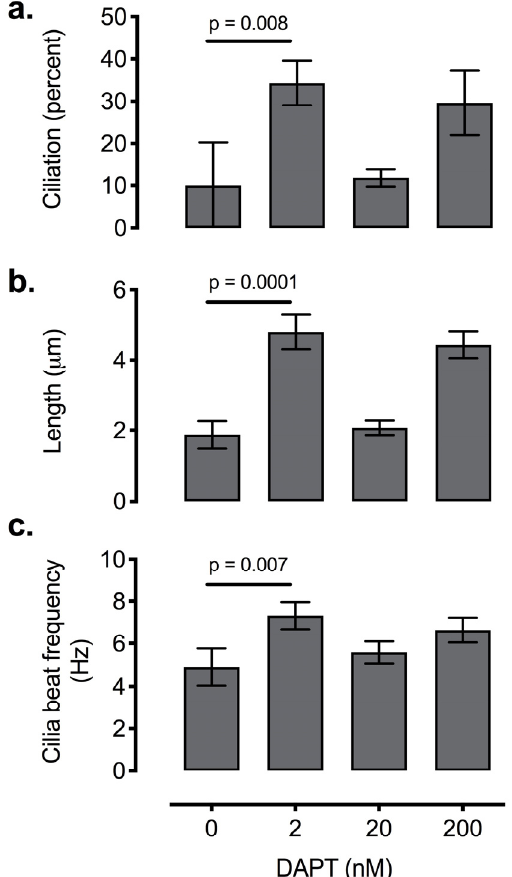
Figure 5. Effect of varying concentrations of DAPT, a Notch antagonist, on ciliation of mouse tracheal epithelial cells ( a ). Addition of 2 nM of DAPT resulted in ~40% greater degree of ciliation over control media. However, concentrations of DAPT at 2 µ M were cytotoxic. DAPT 2 nM also significantly increased cilia length ( b ) and ciliary beat frequency ( c ). Error bars represent ± 1 SD.